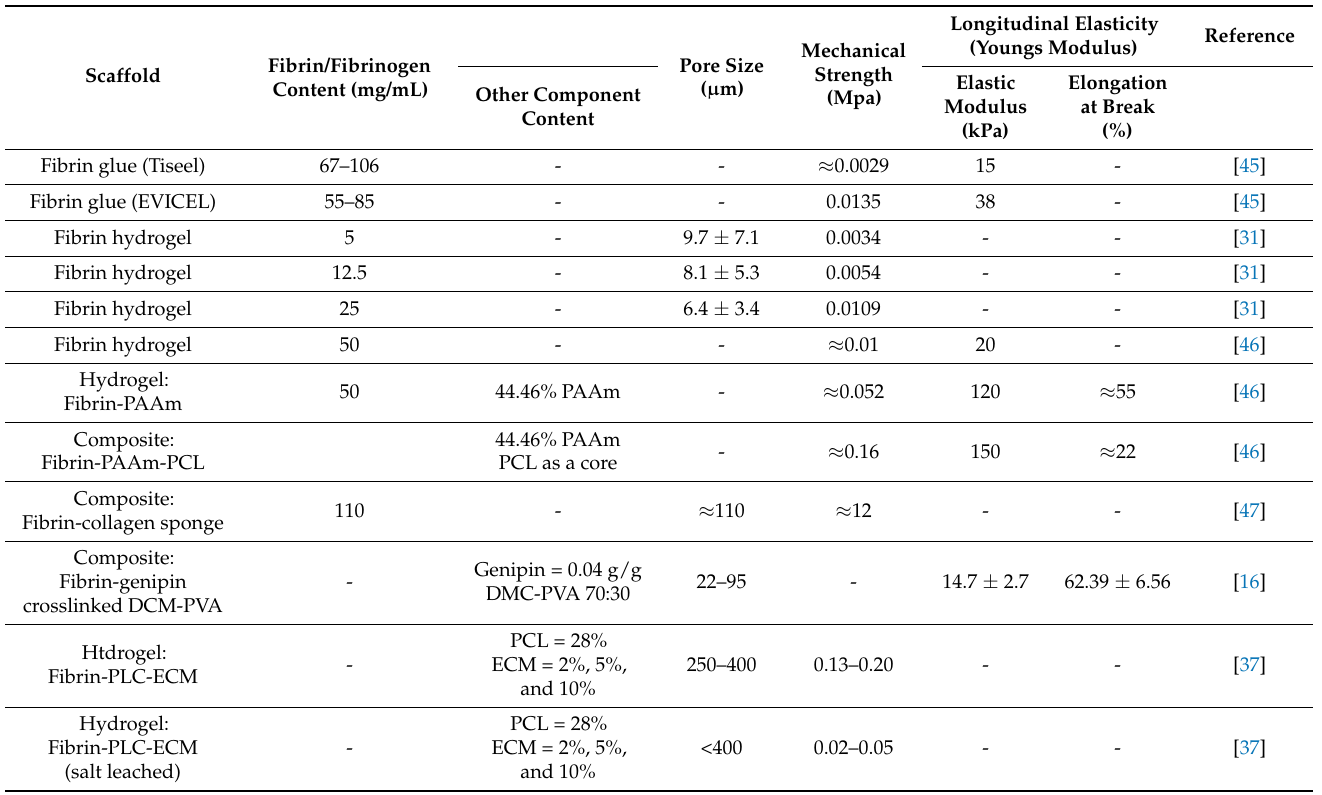
Table 1. Physical and mechanical properties of composed scaffold with